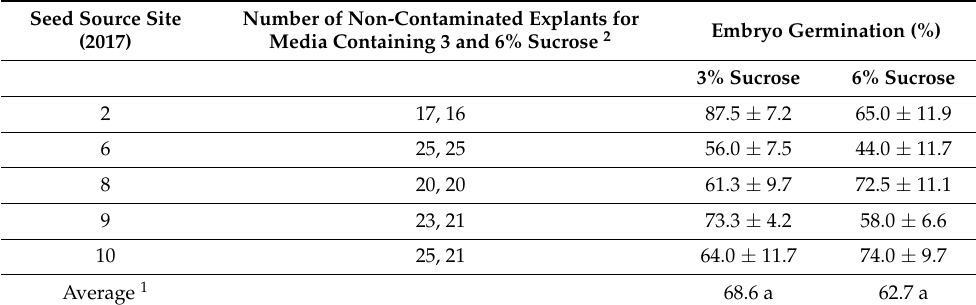
Table 2. Xerophyllum asphodeloides embryo germination percentages after seven weeks for different source sites (2017) on ½ MS medium with different sucrose concentrations.